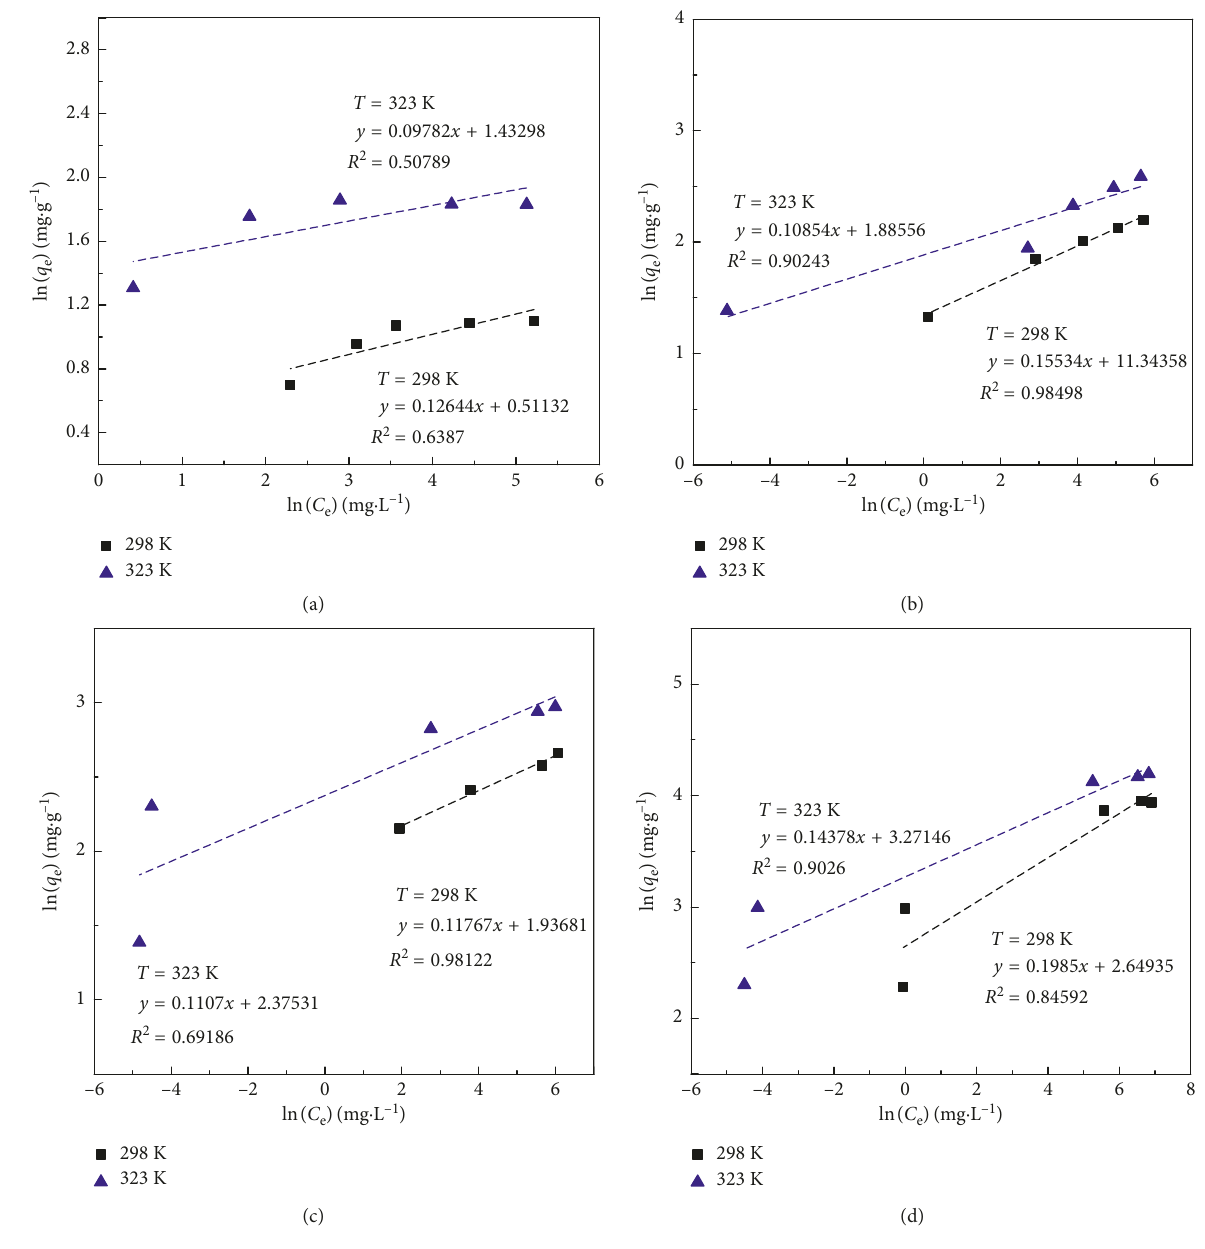
Figure 9: Freundlich fitting curves of Pb(II) adsorption. Table 5: Parameters of the Langmuir and Freundlich isotherm